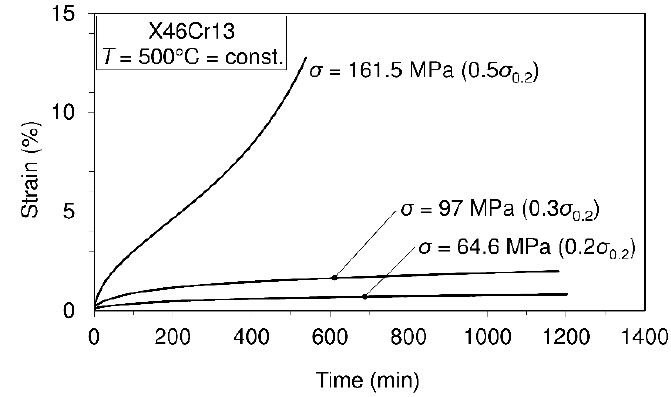
Figure 7. Short-time creep tests of steel X46Cr13 at the temperature of 500 °C.